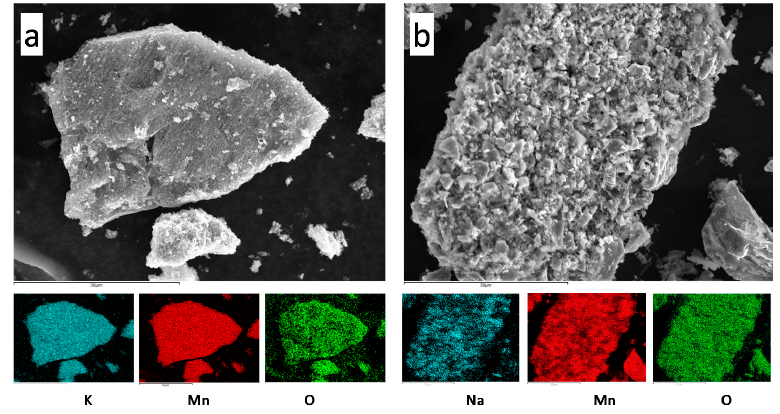
Figure 3. FESEM images and composition maps of ( a ) K-B / SS, ( b ) Na-B / SS.